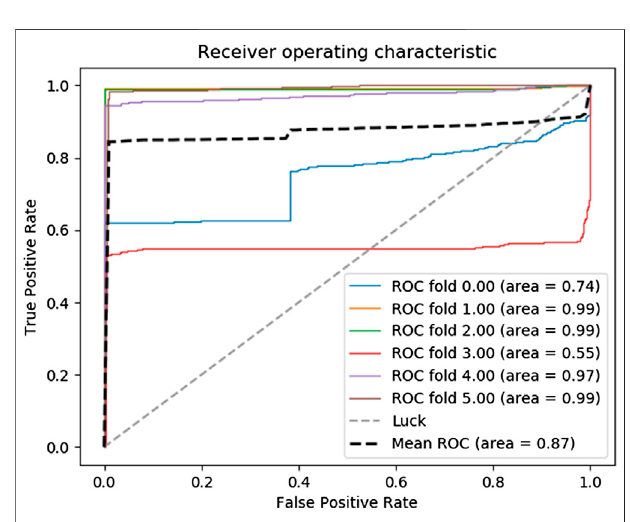
FIGURE 7 | Receiver operating characteristic of raw data.